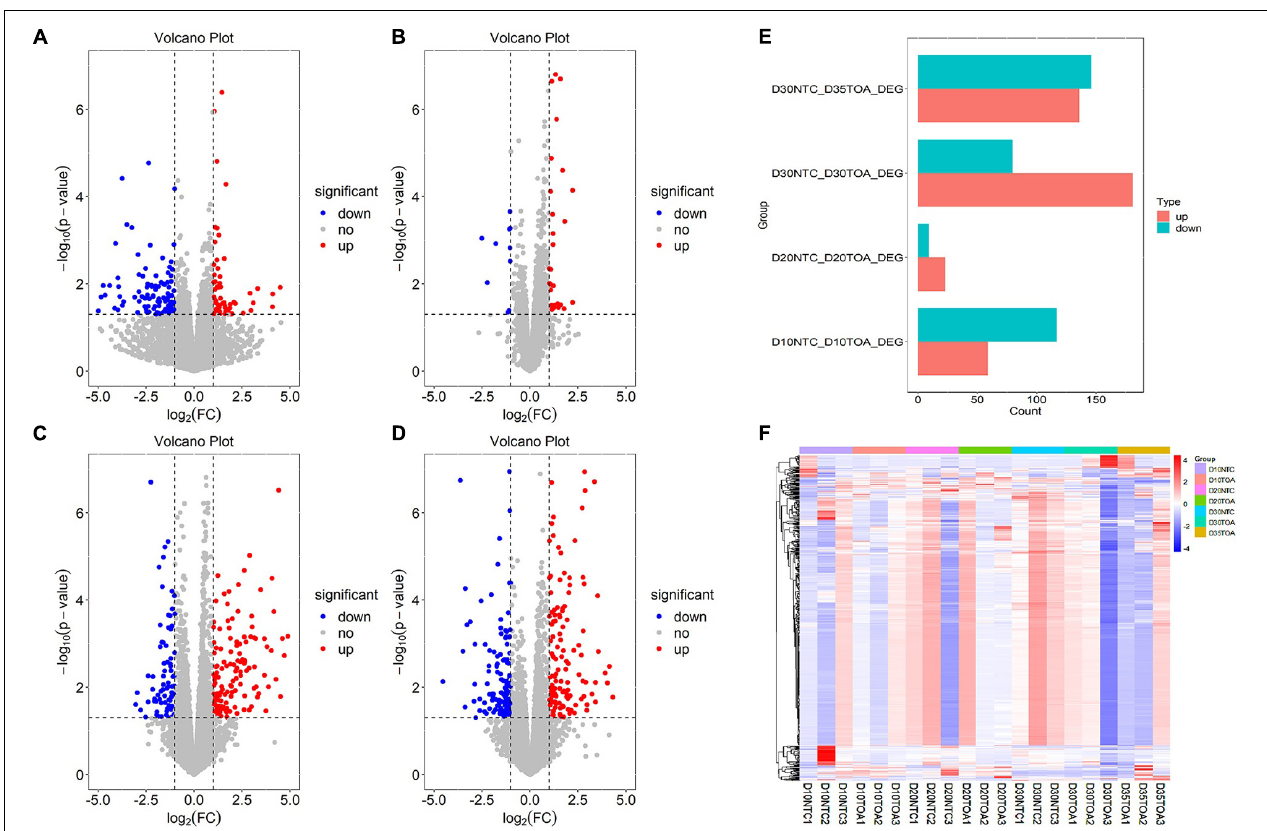
FIGURE 1 | Differentially expressed analysis in comparison groups. The differential expression analysis in two groups was taken as follows: D10NTC vs. D10TOA group (A) , D20NTC vs. D20TOA group (B) , D30NTC vs. D30TOA group (C) , and D30NTC vs. D35TOA group (D) with p ≤ 0.05 and | FC| ≥ 2 and visualized by R software with ggplot2 package. Red dots mean up-regulated genes, blue dots mean down- regulated genes, and gray dots mean no difference genes. The DEGs details were visualized by bar-plot with ggplot2 package (E) , and the differential expression heat-map in every sample was visualized by R software with pheatmap package (F) . In bar-plot, red indicated the up-regulated gene, and green indicated the down-regulated gene in comparison groups. In heat-map, each column represented one sample, and each row referred to a gene. The color legend was on the top-right of the figure, and compound relative abundances were standardized prior to unsupervised hierarchical clustering of samples (rows). Red indicated the genes with higher expression relative to the geometrical means; blue indicated the genes with lower expression relative to the geometrical means. The color legend indicated the sample